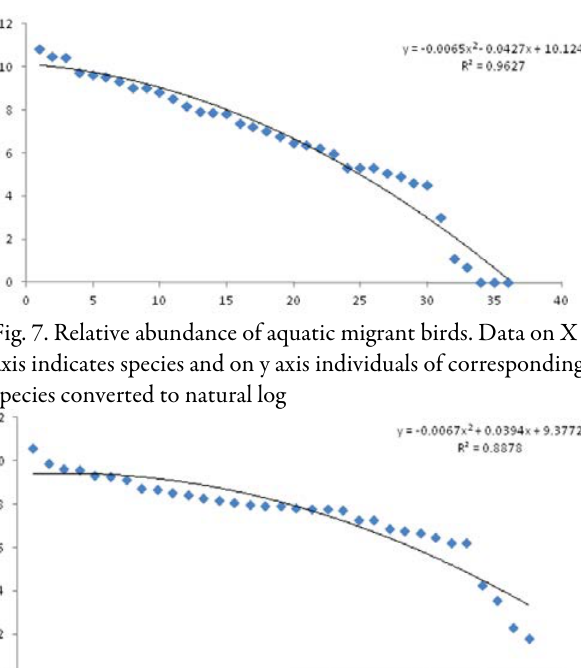
Fig. 6. Relative abundance of non-aquatic birds in wetlands of UP. Data on X axis is number of species encountered and Y axis number of individuals of corresponding species observed, converted to natural log